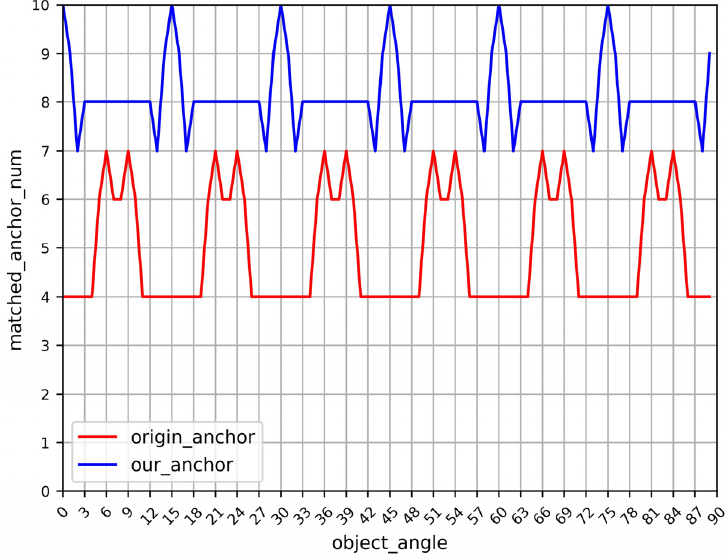
Figure 2. The number of anchors matched to a target under the same IOU threshold. Baseline’s matching methods greatly fluctuate at either 4, 6 or 7, with a variance of 1.396, which will produce great unfairness in matching. Our method has small fluctuation, most of which are 8, and a few are 7 and 10, and the variance is 0.5, which is fairer in matching when the receptive field is appropriate.